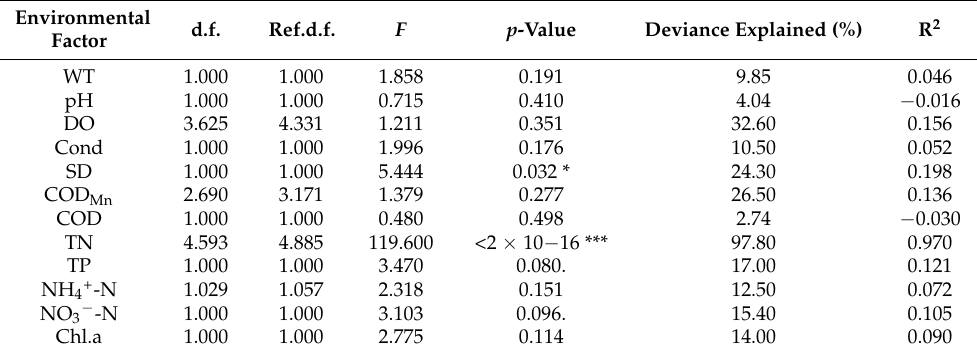
Table 3. GAM model analysis of TOC concentration and environmental factors in the Danjiangkou Reservoir in Winter.